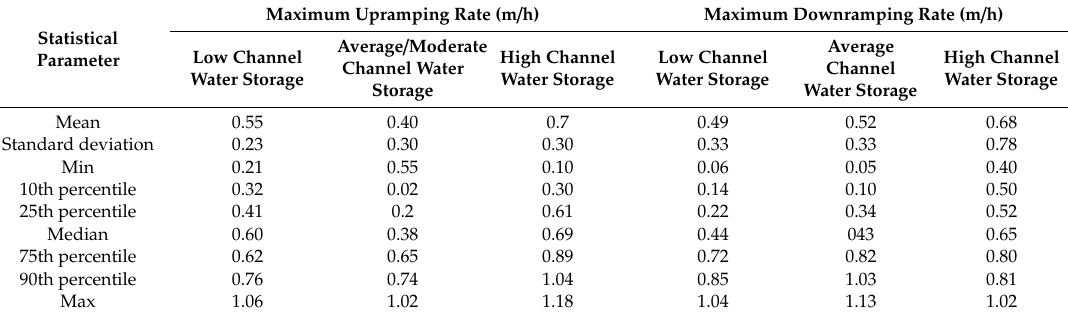
Table 2. Statistics of upramping and downramping rates based on data from Kaunas HPP gauging station (data sample: n = 840, 1440 and 830 for low, average and high river channel water storage,